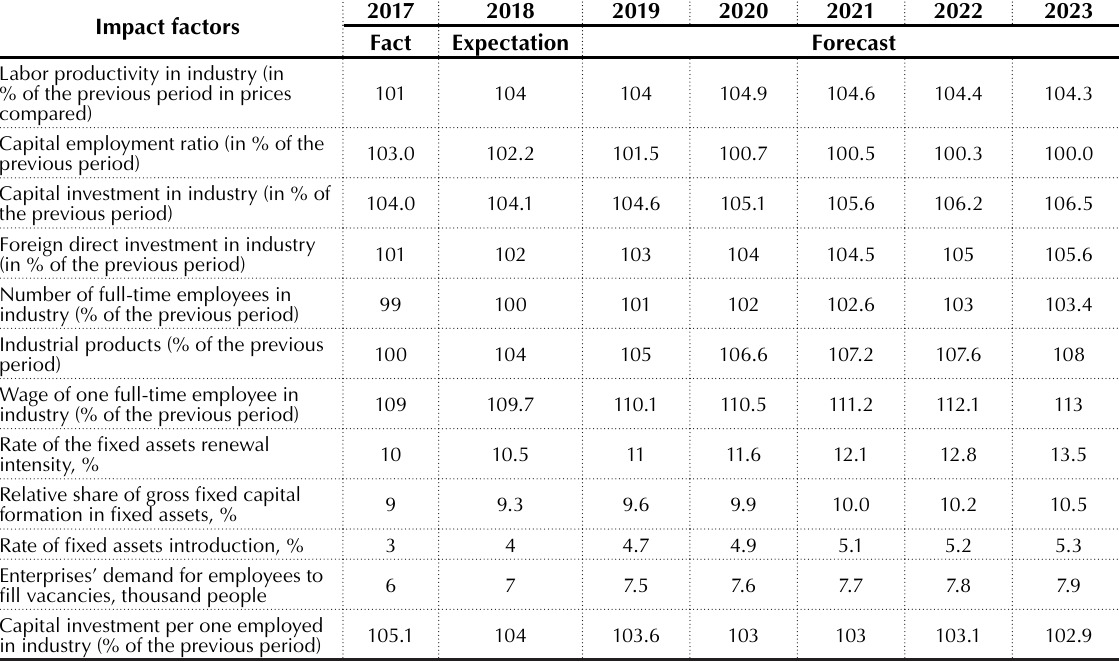
Table 5. Forecasting factors for calculating the number of new workplaces in the processing industry in 2019–2023